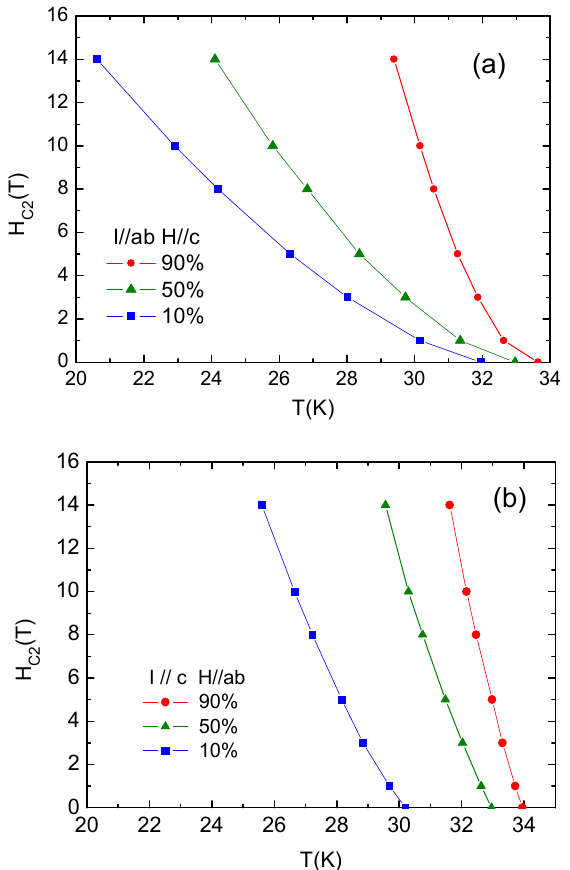
Figure 7. Temperature dependence of the upper critical field H c 2 ( T ) with ( a ) H //c and( b ) H //ab. The temperature dependence of the H c2 anisotropy parameter Γ H = is presented in Figure 8. Γ H taken at 90% resistivity drop reaches 8 near T c , which is very close to the